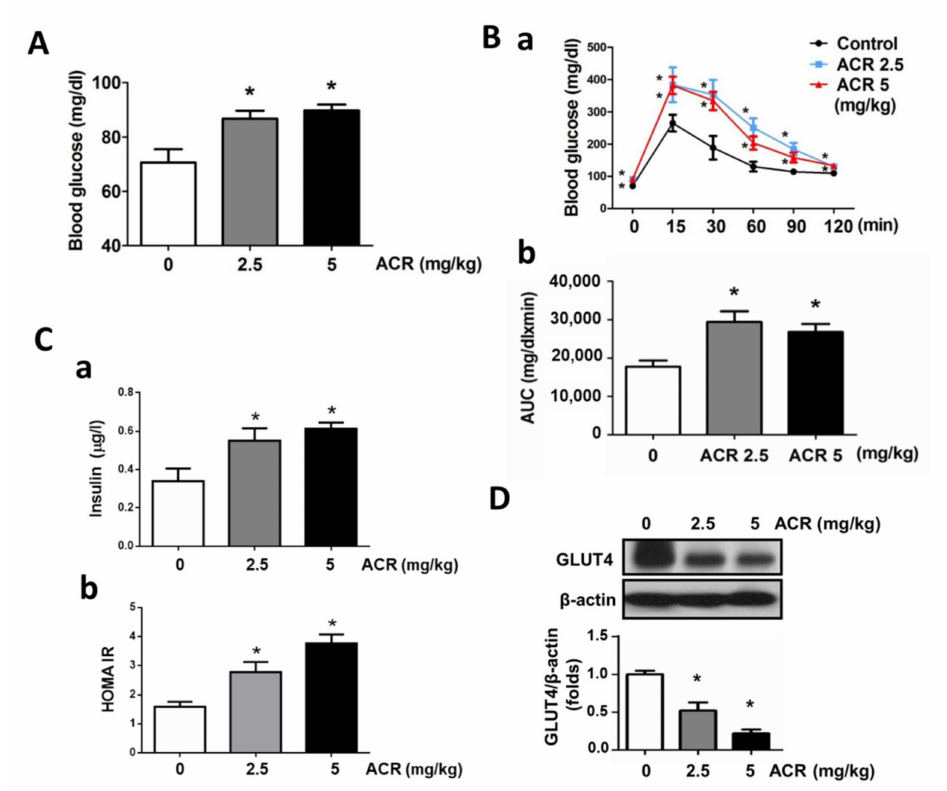
Figure 1. Effects of acrolein on blood glucose, glucose tolerance, blood insulin, HOMA-IR, and muscle GLUT4 protein expression in mice. Mice were treated with acrolein (2.5 or 5 mg/kg) by oral gavage daily for 4 weeks. The fasting blood glucose levels ( A ), OGTT ( B-a ), glucose area under the curve (AUC) ( B-b ), insulin levels ( C-a ), and HOMA-IR ( C-b ) were shown. ( D ) The GLUT4 protein expression in the soleus muscles was determined by Western blotting and quantified using densitometric analysis. Results are presented as means ± SEM (n = 8). * p < 0.05 versus vehicle